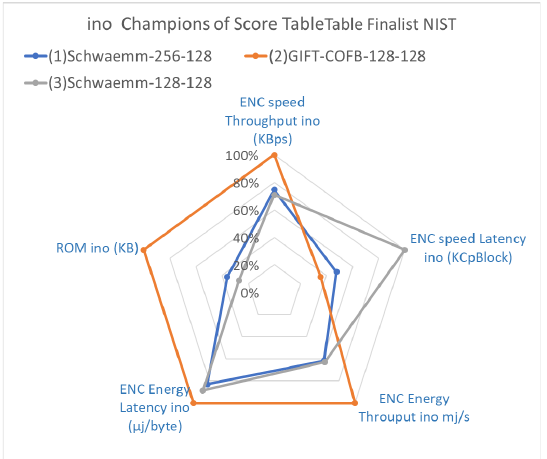
Figure 29. Radar graph of the three NIST finalists winners in 5 measures in UNO.